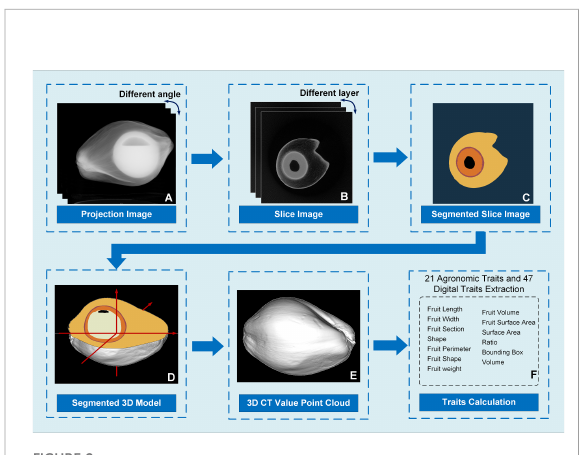
FIGURE 2 Image analysis pipeline of Micro-CT system. (A) As the coconut sample rotated, 360 X-ray projected images at different angles were acquired and calibrated; (B) A FDK algorithm was applied to obtain a reconstructed section image of the coconut fruit; (C) A DeepLabV3 + model was used to segment the slice image and acquire the area of the mesocarp, endocarp, solid and liquid albumen and cavity; (D) A local least squares and a Poisson surface reconstruction algorithm were introduced to convert the boundary points into a 3D model; (E) Filled the 3D model to obtain the 3D cloud point with CT value; (F) Using the segmentation results of the slice images, the 3D model was